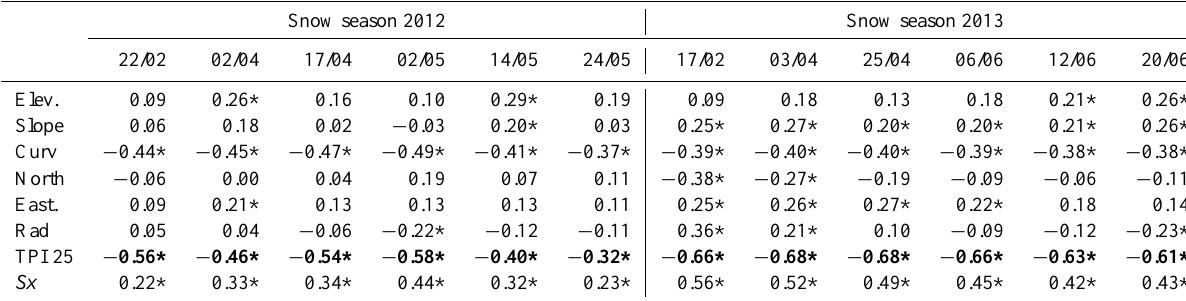
Table 3. Pearson’s r coefficients between SD and the topographic